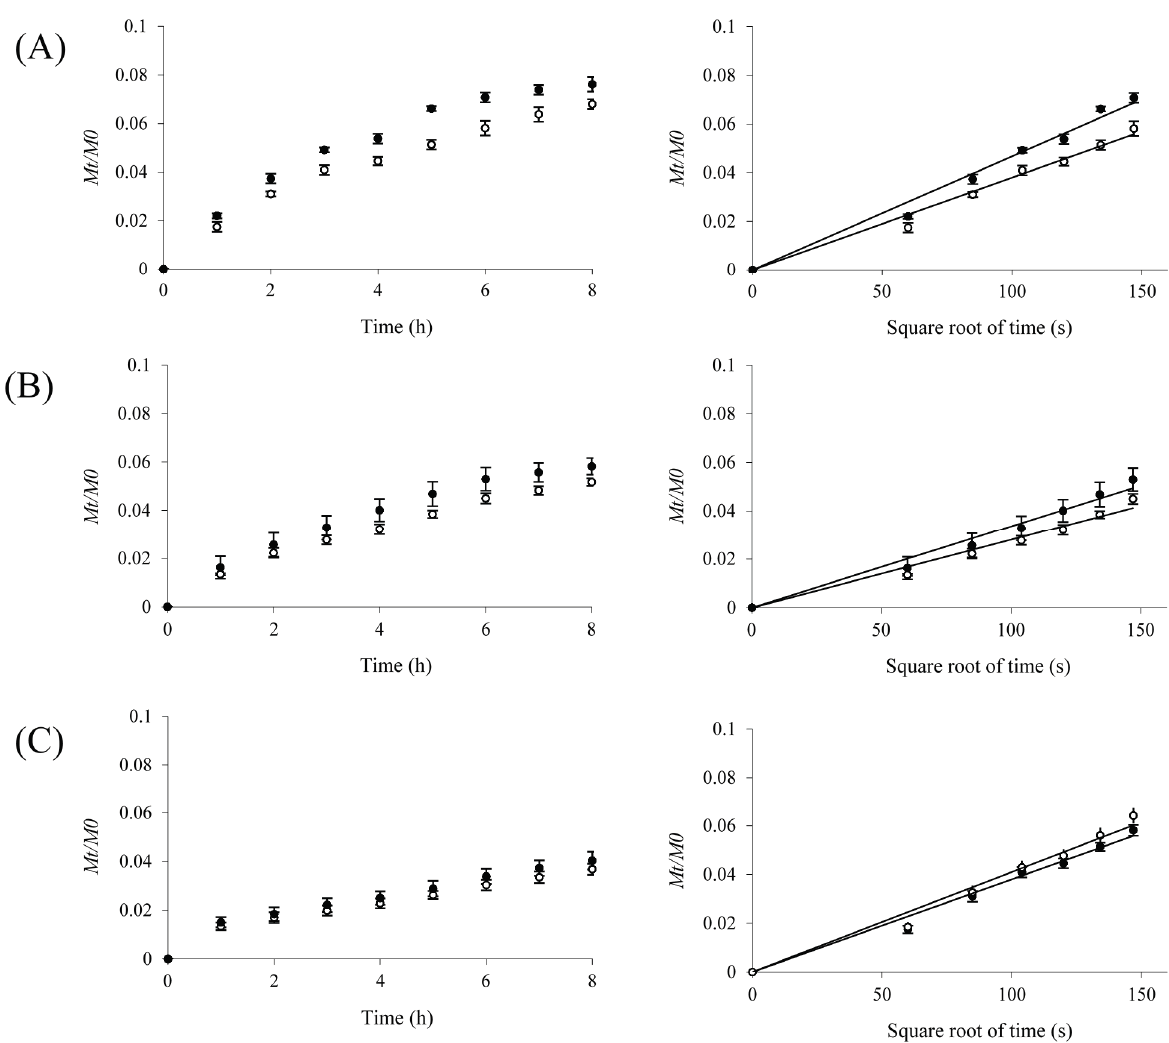
Figure 2. Cumulative release ( M t / M 0 ) of insulin ( A ), ovalbumin ( B ) and bovine serum albumin ( C ) from wheat bran arabinoxylan (WBAX) gels as a function of time and as a function of root time. Protein release was followed at 25 °C and 90 rpm during 8 h. Gels at protein/WBAX mass ratios of 0.06 ( Ο ) and 0.12 ( ● ).